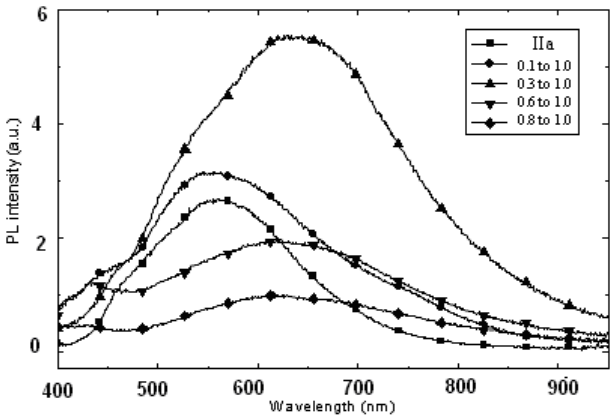
Figure 11. Photoluminescence study of CdS: IIa nanocomposites at different mass compositions